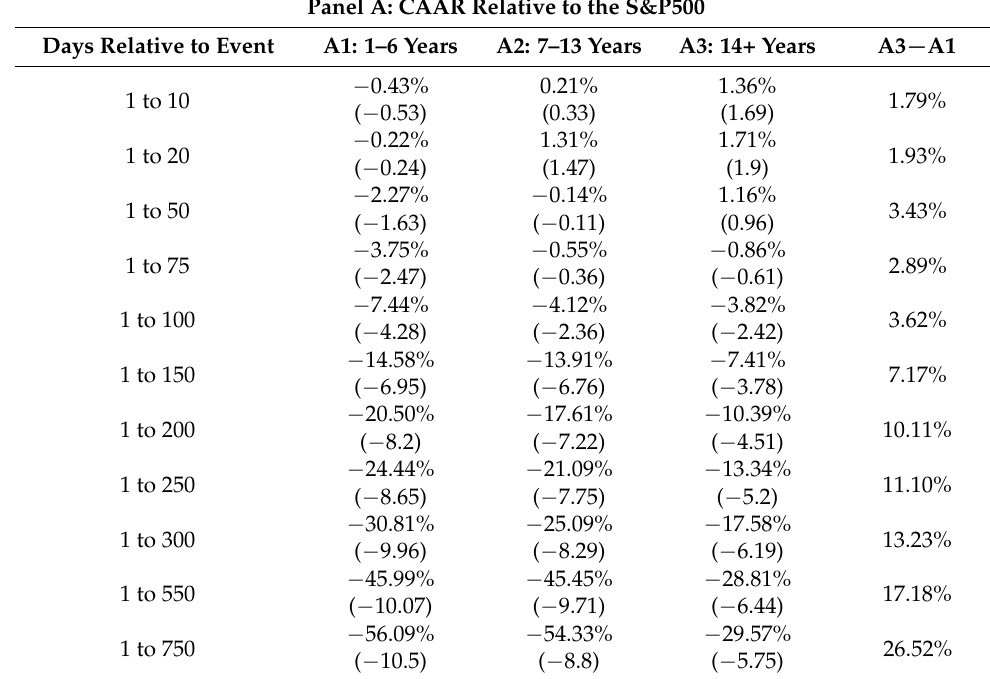
Table 5. Age-Ranked Portfolios and the Performance of